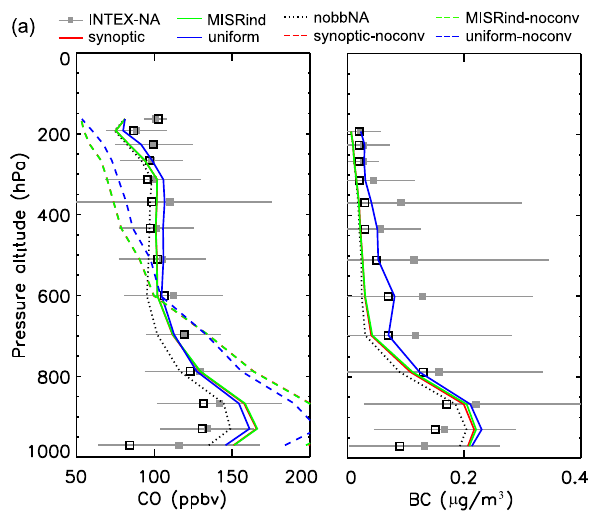
Fig. 9a. Comparisons of vertical CO and BC profiles from model simulations and from measurements during the 2004 INTEX-NA experiment for all flights. Grey points and bars are mean values and standard deviation of the observations at each level. Black squares are median values of the observations at each level. All model re- sults are sampled along the flight trajectories.